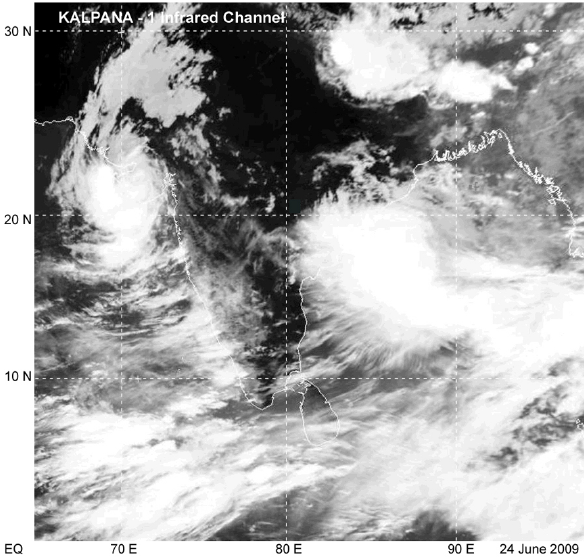
Figure 6. NOAA’s contour image of outgoing long-wave radiation activity over Indian subcontinent on 24–25 June 2009.